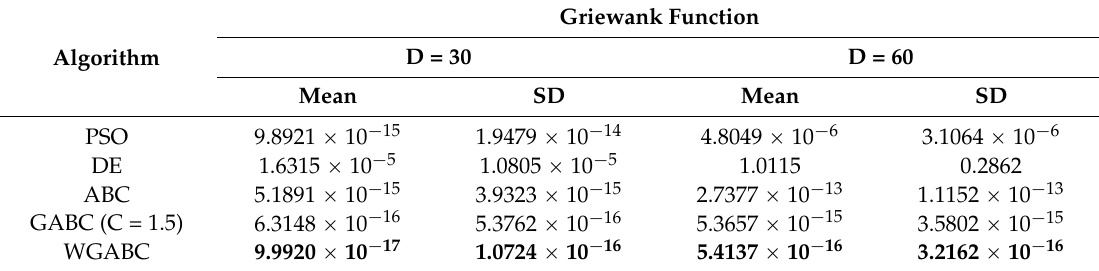
Table 7. The mean and standard deviation of the Griewank function on the different